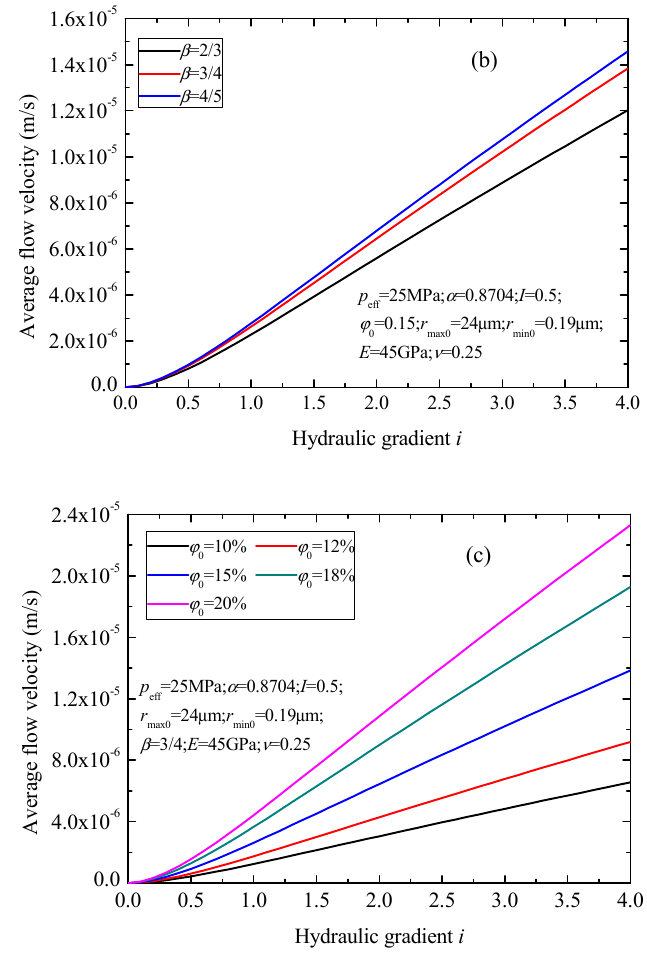
Figure 5. The average flow velocity curves: ( a ) for different rock elastic modulus; ( b ) for different power law index; ( c ) for different initial porosity.